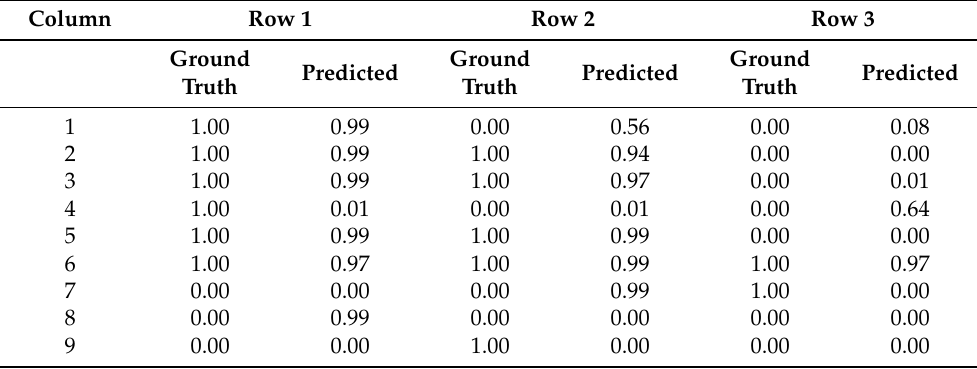
Table 7. Small model results on the testing